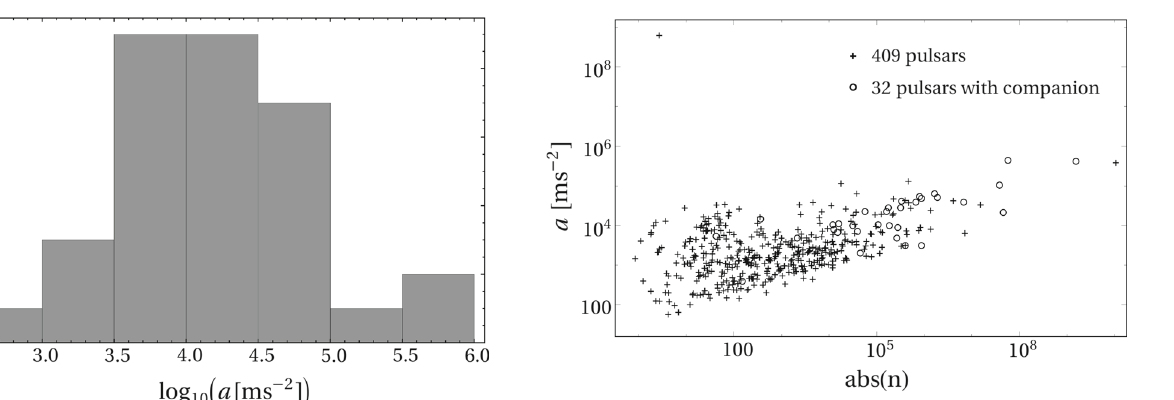
Fig. 6 Cumulative distribution of estimated acceleration for the 32 pulsars with companions